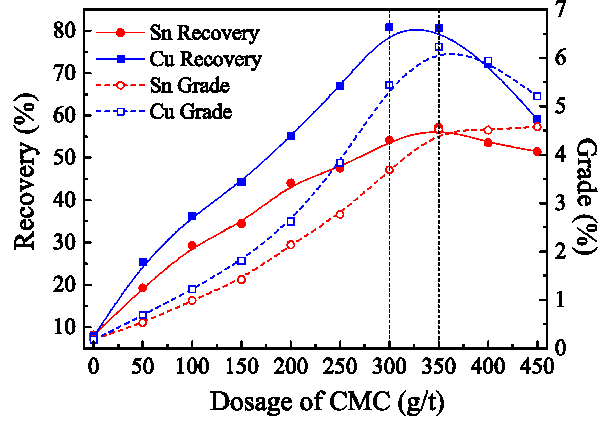
Figure 5. Flotation recovery and grade of Sn and Cu as a function of dosage of CMC (pH = 7.2–7.5; SSF 250 g/t; lead nitrate 200 g/t; BHA 2000 g/t; terpineol 25 g/t).